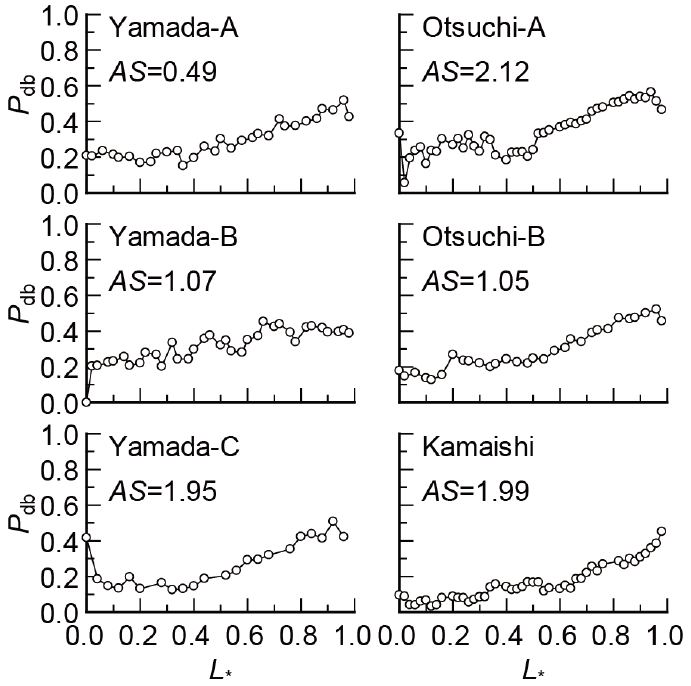
Figure 6. The relationship between P db and L * in each analysis area—from Imai et al. [6]. The relationships between NDT and i M , L * , and D * were examined using data from all analysis regions (Figure 7). NDT was higher when 80% < i M < 100% and 0.0 < L * <